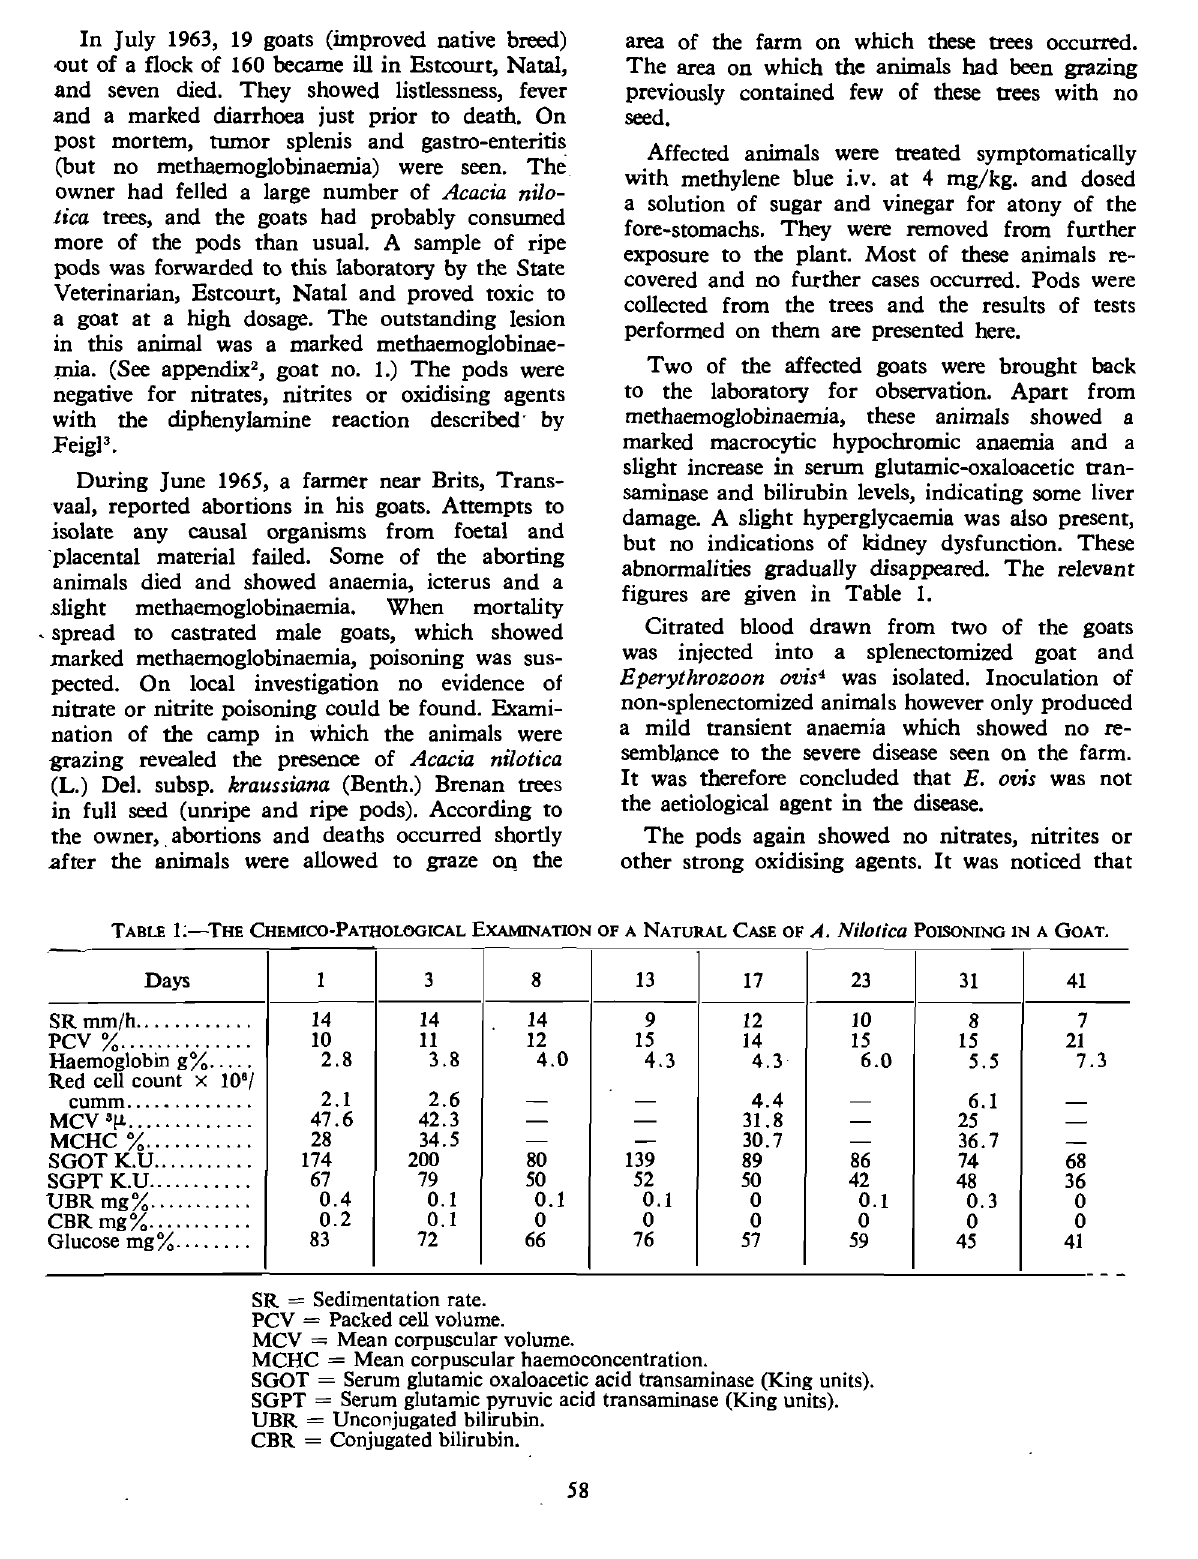
SR = Sedimentation rate. PCV = Packed cell volume. MCV = Mean corpuscular volume.